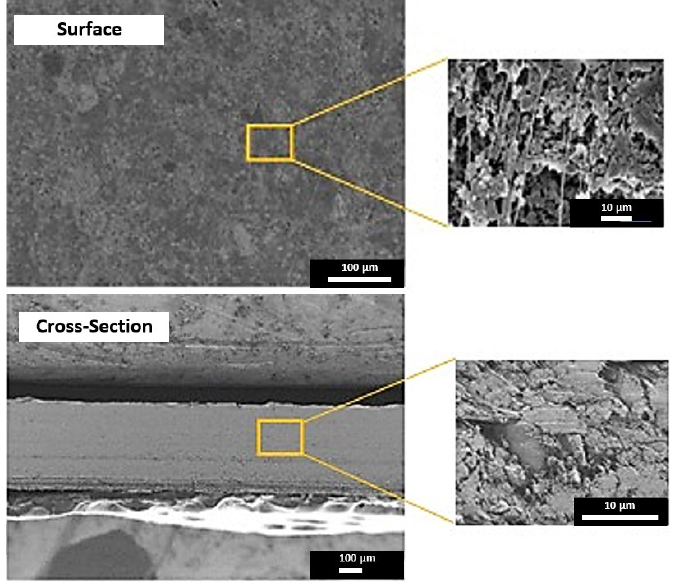
Figure 4. SEM images of the surface and cross-section of our prepared BN/PTFE membrane.